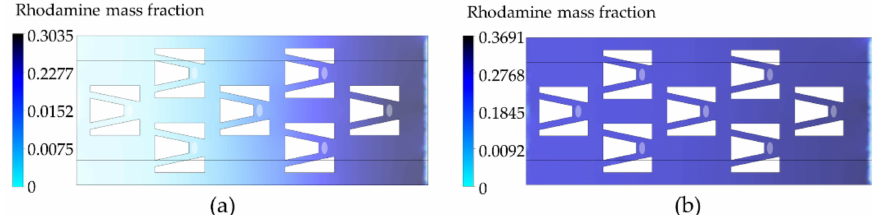
Figure 7. Distribution of rhodamine mass fraction in micro-traps: ( a ) microdroplet and culture solution velocity are 0.03 m/s; ( b ) relative velocity of the microdroplet to culture solution is 0.06